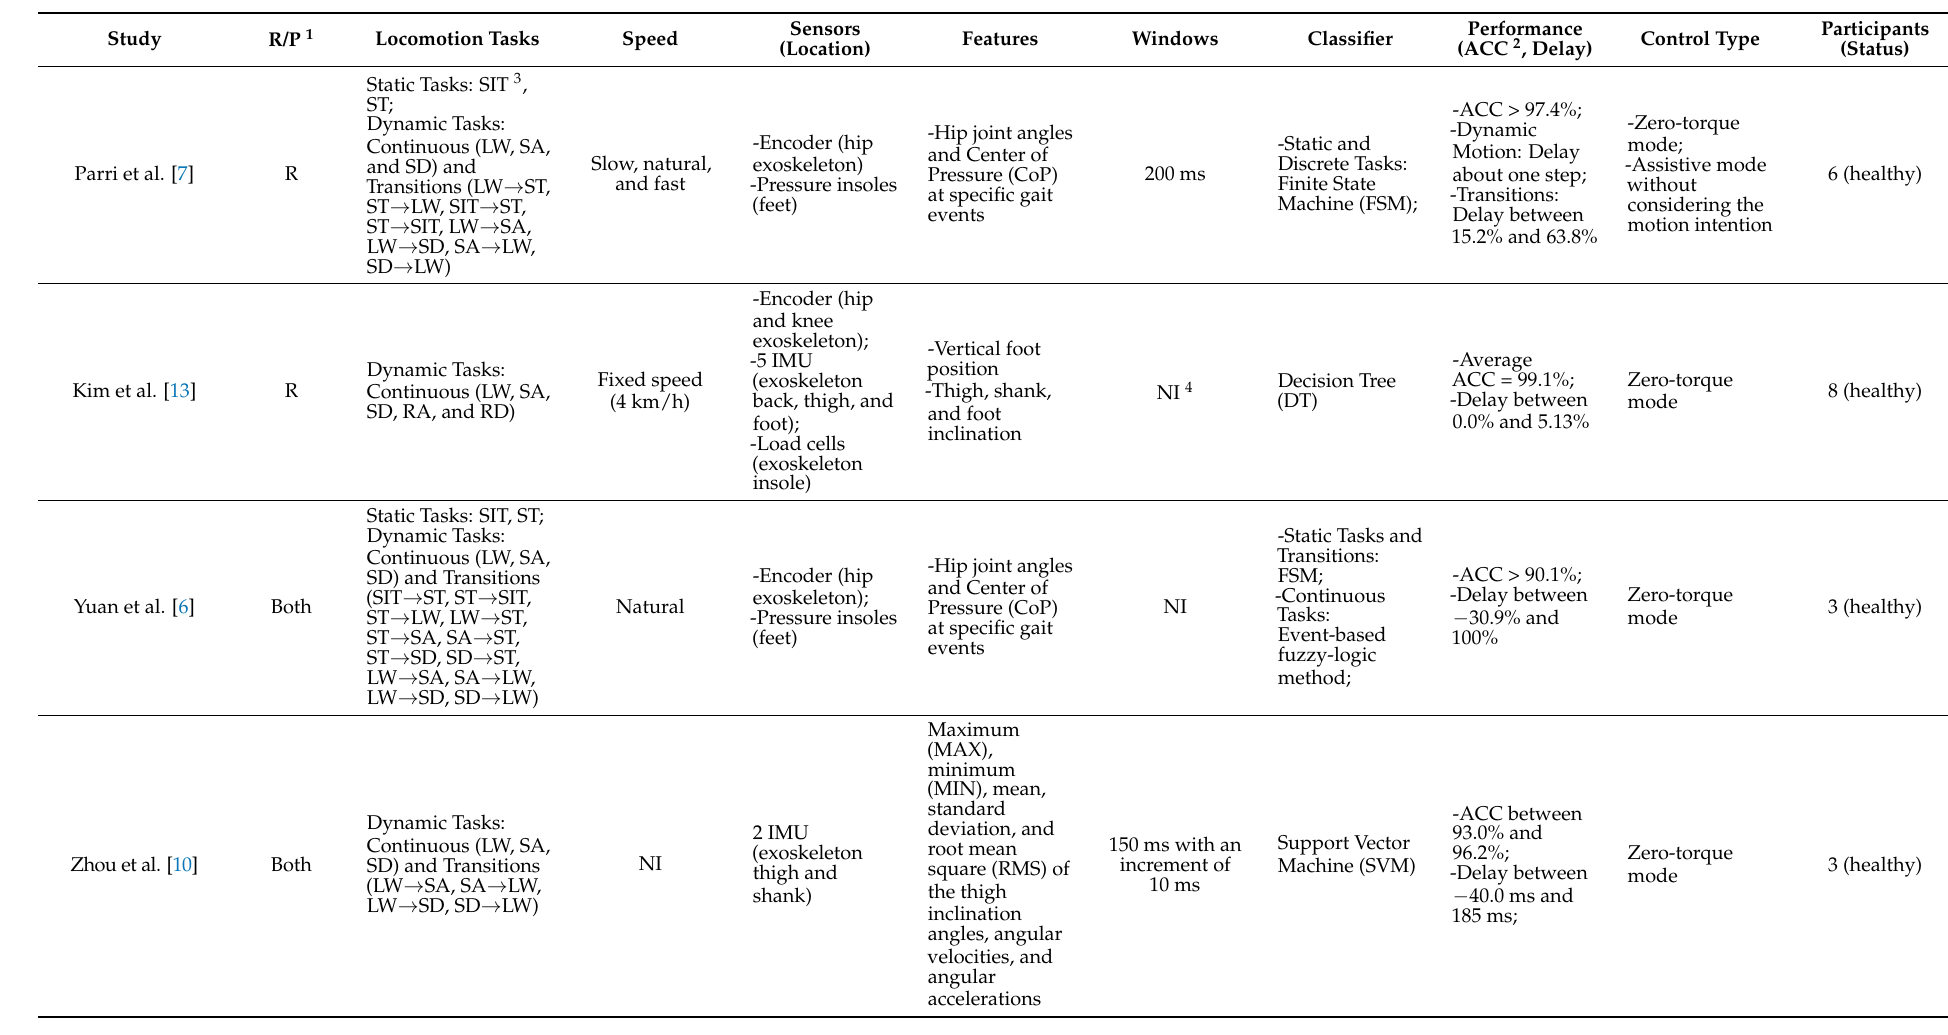
Table 2. LM decoding algorithms available in the